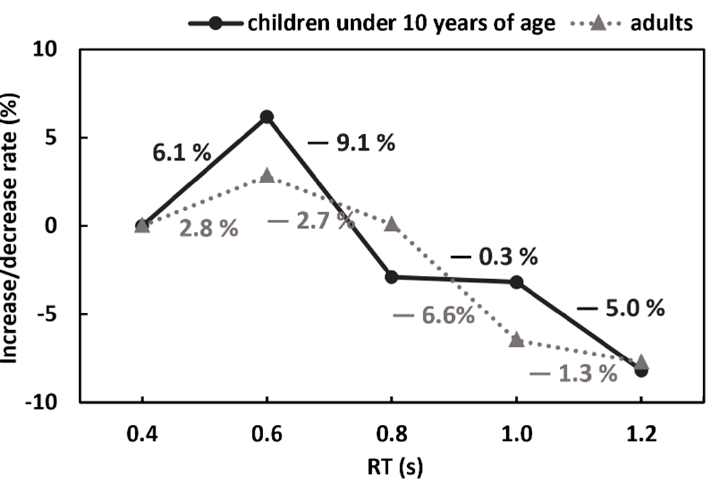
Figure 8. Comparison of speech intelligibility test scores in children and adults.